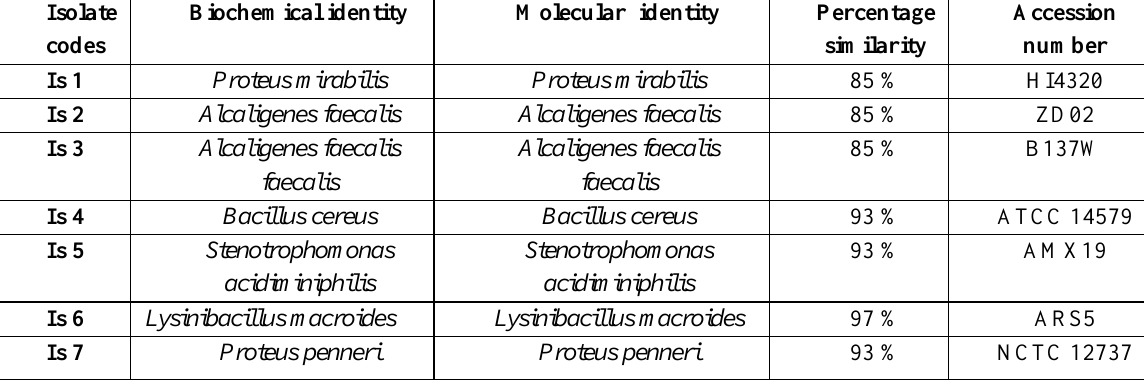
Table 2. Molecular identification of multidrug resistant bacterial isolates.